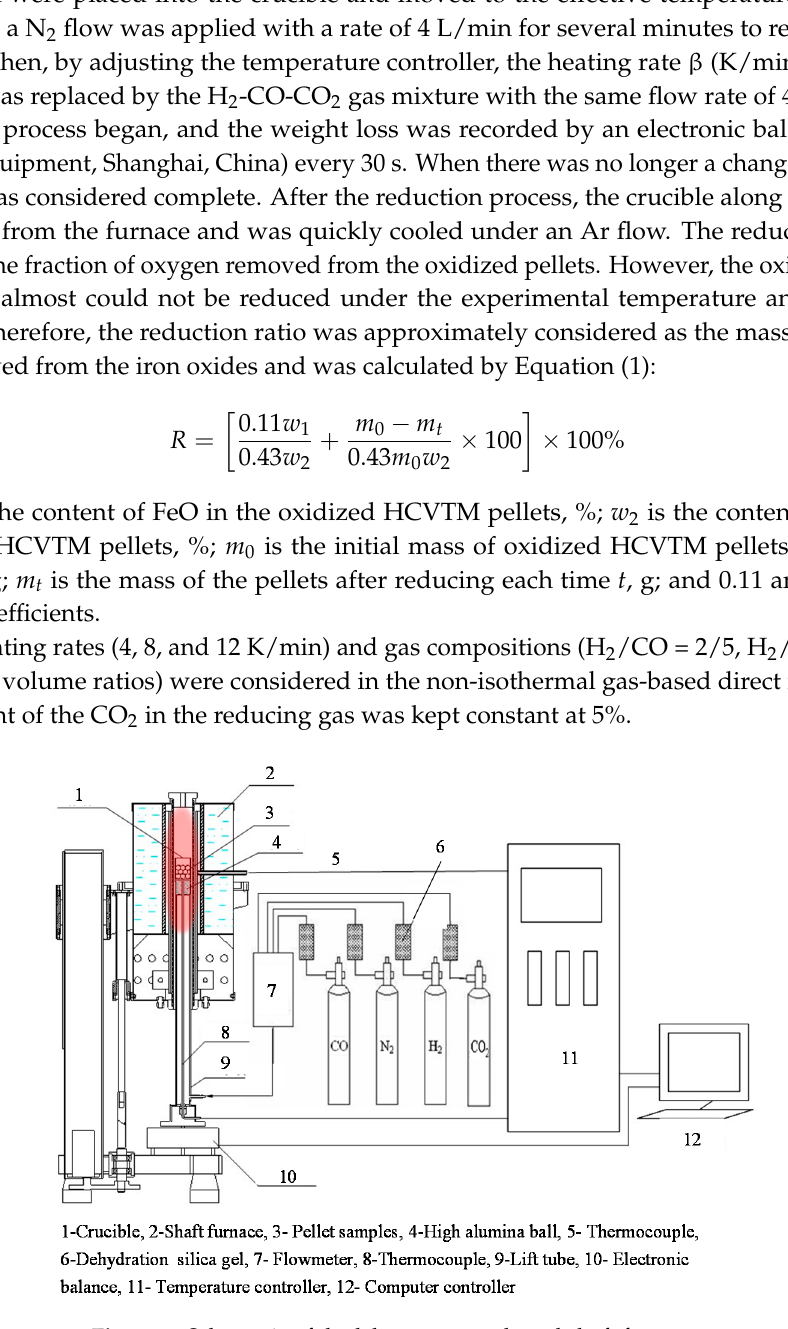
Figure 6. Schematic of the laboratory gas-based shaft furnace.